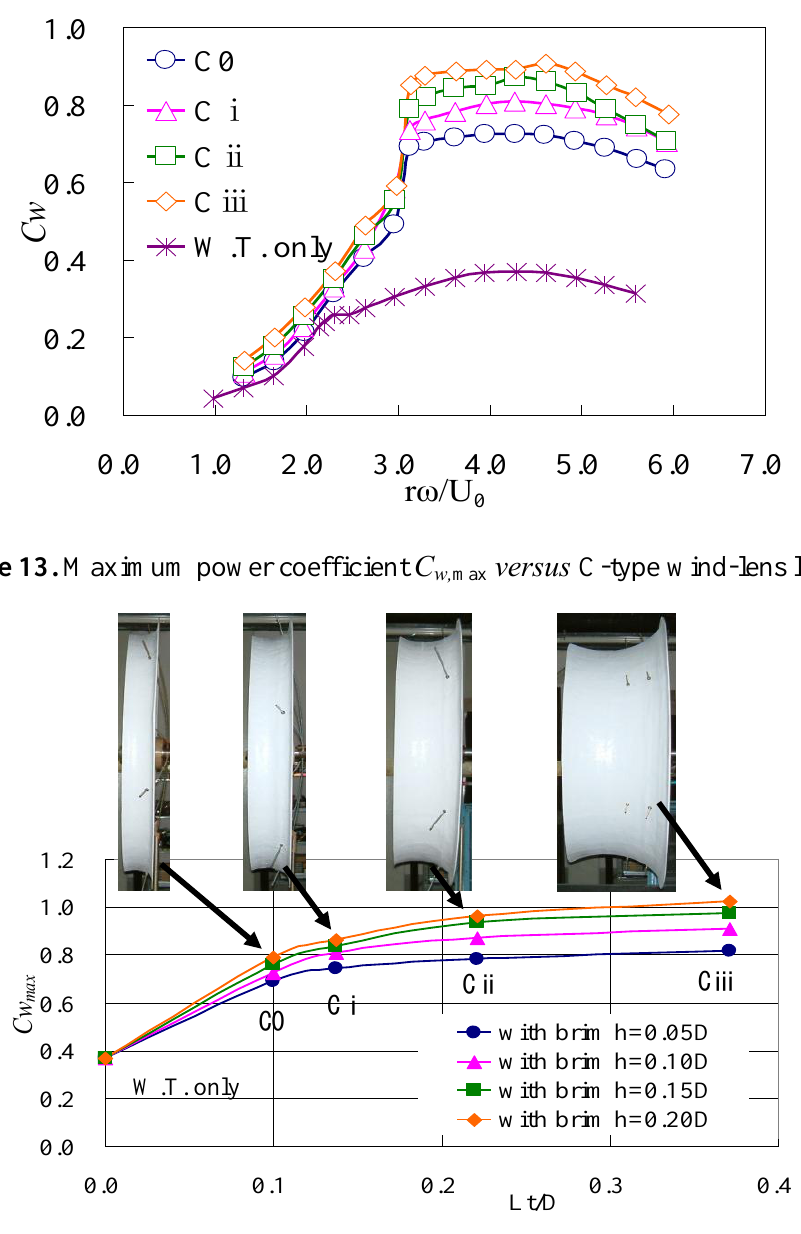
Figure 12. Power coefficients C For C0–Ciii diffuser, see Figure 13.